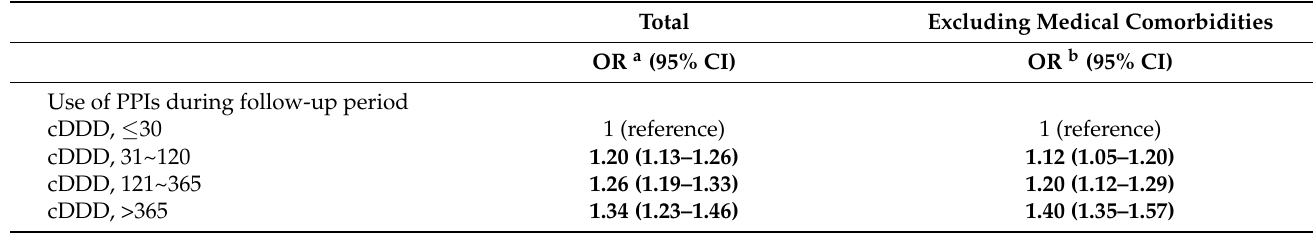
Table 3. Sensitivity test of risk of type 2 diabetes among patients who were exposed to PPIs. Total Excluding Medical Comorbidities OR a (95% CI) OR b (95% CI)